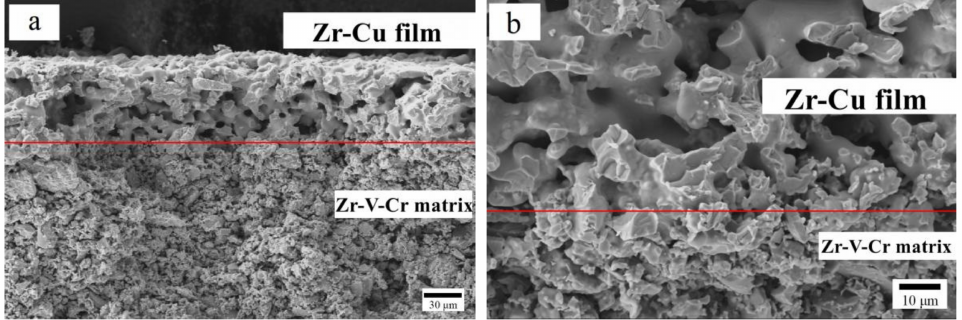
Figure 8. Faultage image at the interface of (Zr 98 Cu 2 )/(Zr-V-Cr) getter by HITACHI SU1500. ( a ) 300 × SEM; ( b ) 1000 ×